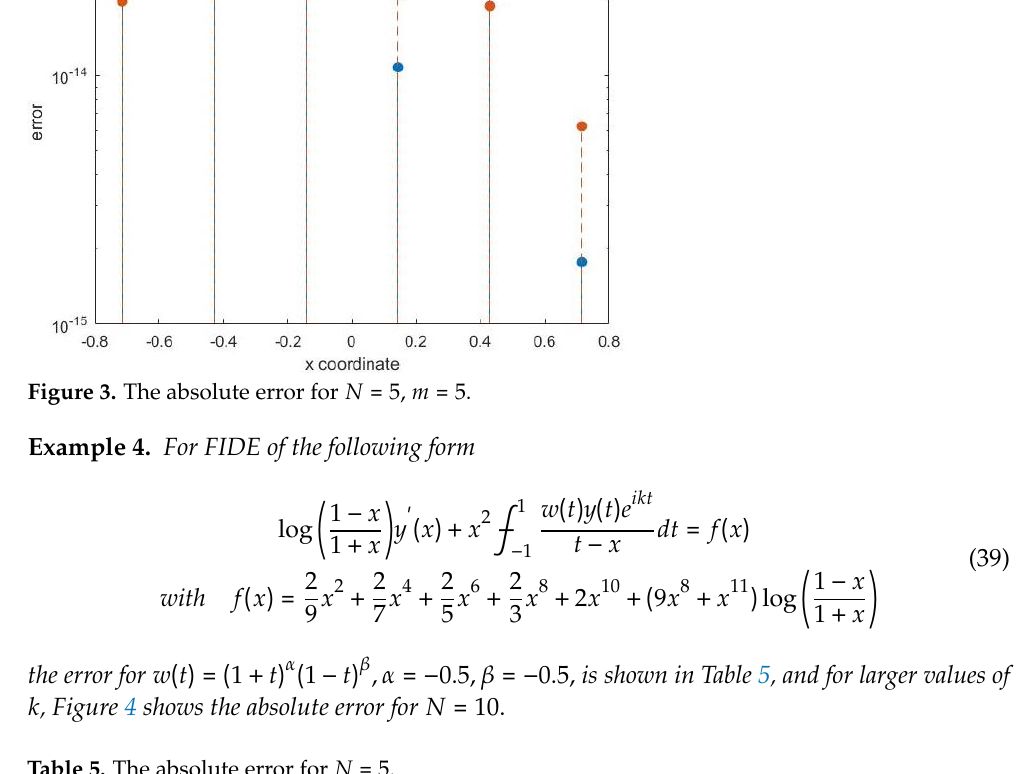
Table 5. The absolute error for N = 5.